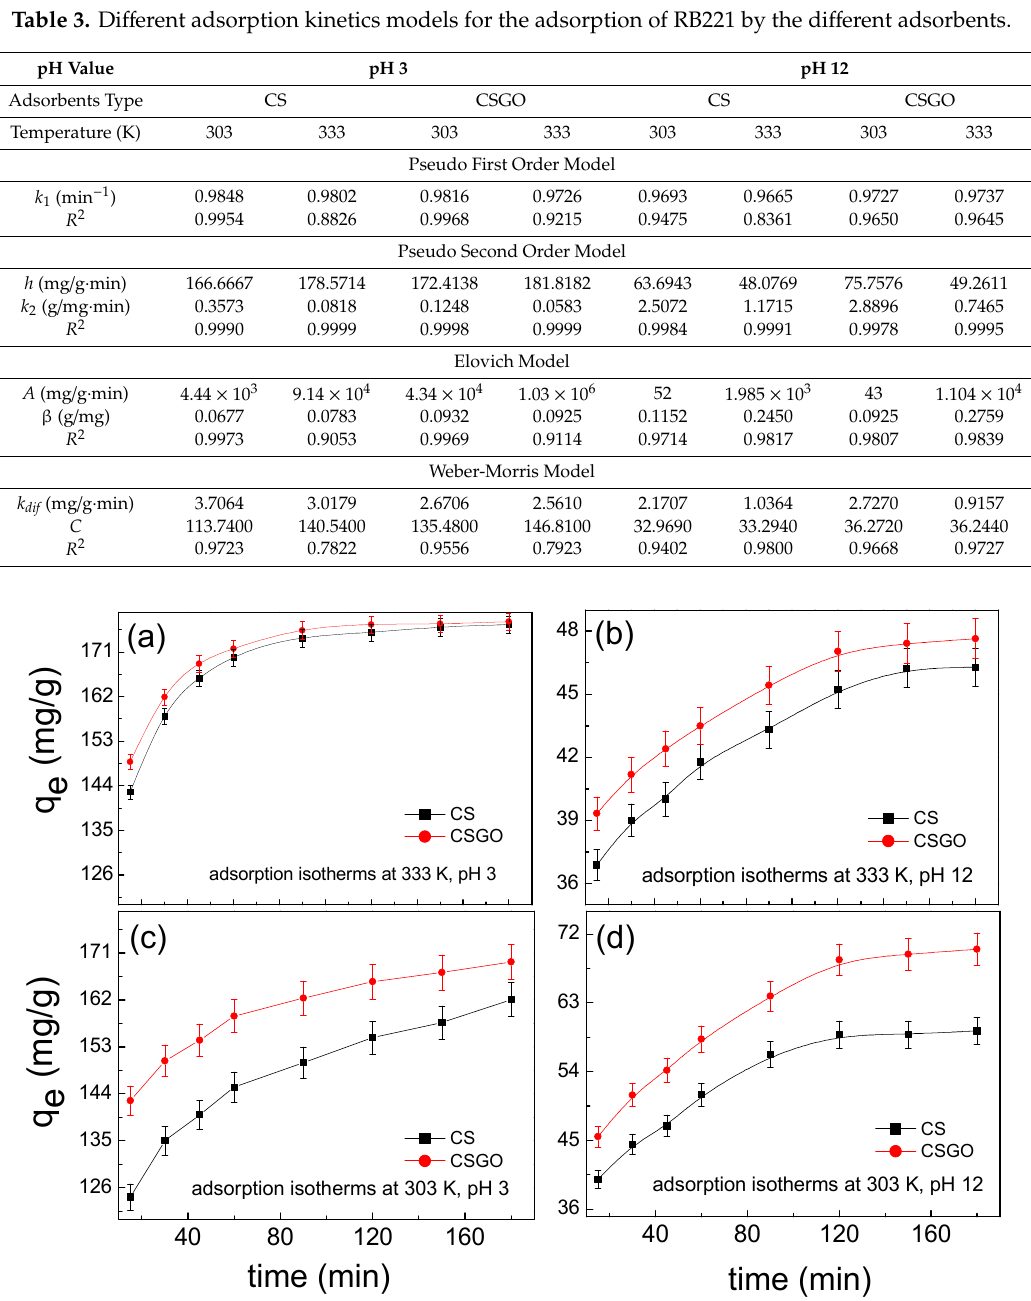
Table 3. Different adsorption kinetics models for the adsorption of RB221 by the different adsorbents.